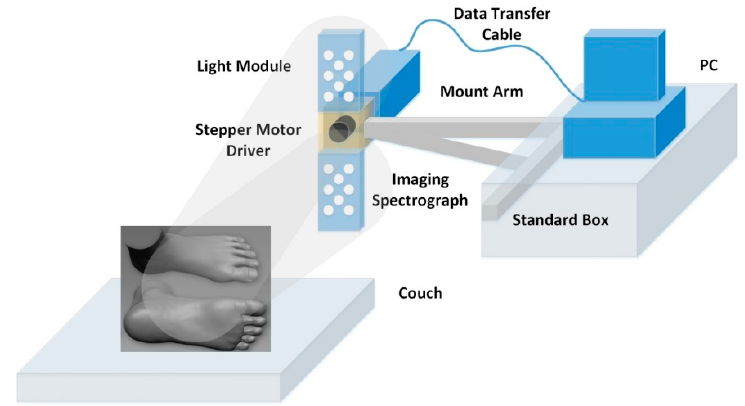
Figure 1. Hyperspectral imaging setup for imaging the foot (foot-to-lens distance typically 25–30